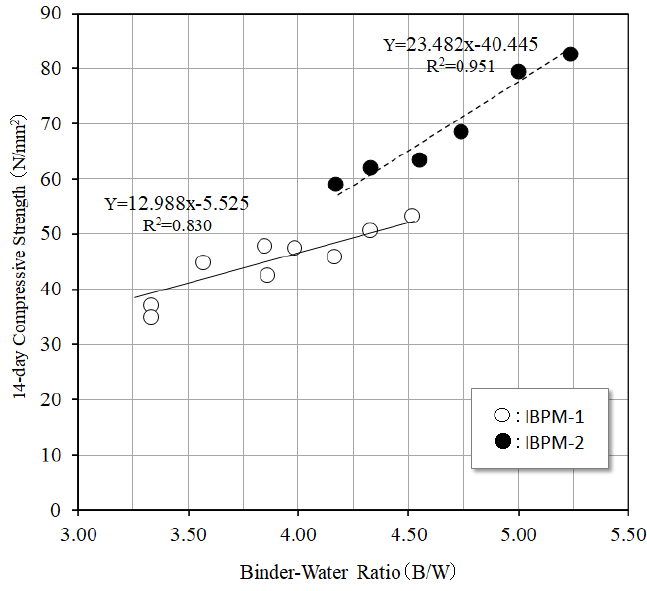
Figure 8. Relationship between the B/W and compressive strength of IBPM